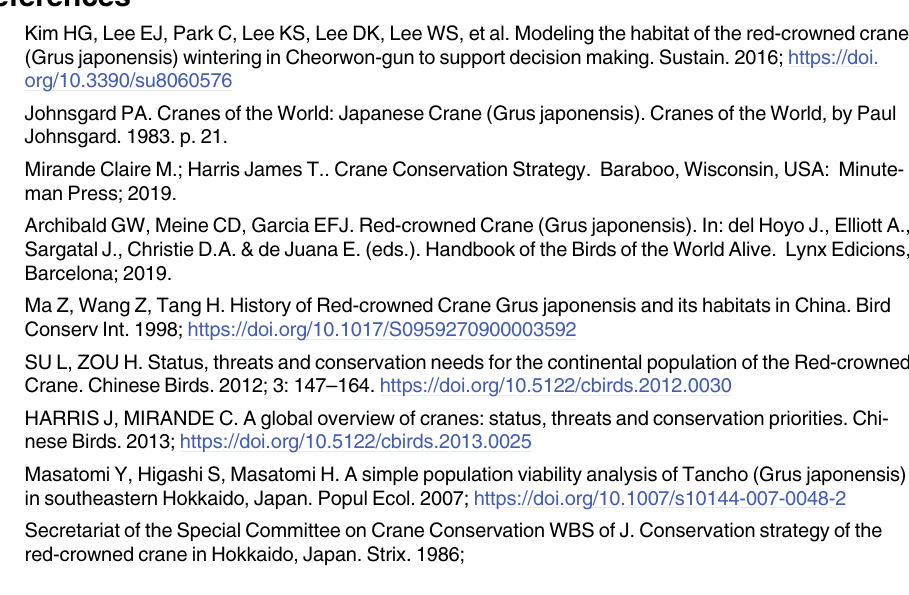
polygons are the predicted potential breeding area under current climate condition, and orange areas are the predicted potential breeding area climate change. Scenario is RCP6.0, intermediate emission scenario. S3 Fig. Predicted breeding range of the continental population of the red-crowned crane at 2030s, 2050s, 2070s and 2080s. Blue polygons are the current actual breeding area, green polygons are the predicted potential breeding area under current climate condition, and orange areas are the predicted potential breeding area climate change. Scenario is RCP8.5, high emission